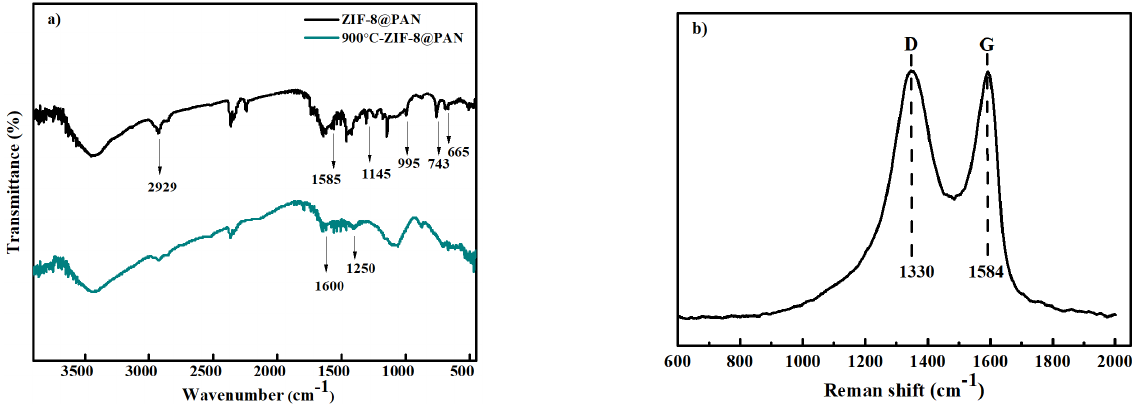
Figure 5. ( a ) FTIR spectra of ZIF − 8@PAN nanofiber membrane and the carbonized ZIF − 8@PAN nanofiber membrane, and ( b ) Raman spectrum of the carbonized ZIF − 8@PAN nanofiber membrane.